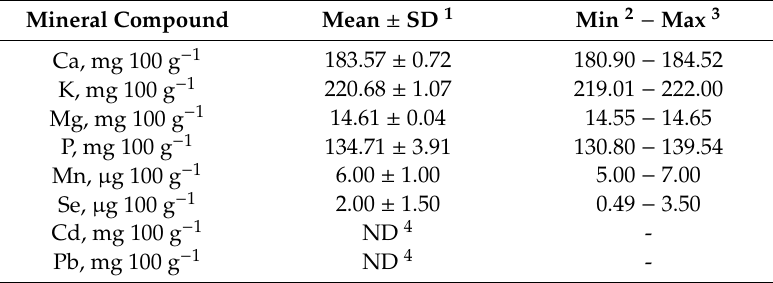
Table 2. Mineral composition of raw goat’s milk.